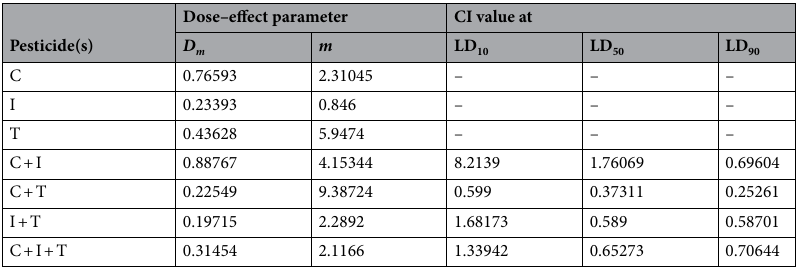
Table 2. Dose–effect relationship parameters and mean combination index (CI) values of chlorpyrifos (C), imidacloprid (I), and thiamethoxam (T) singly and in binary and ternary combinations in bumblebee tests after 48 h of exposure. The computer software CompuSyn was used to calculating the D m , m , r , and CI values. The parameters D m , m , and r are the antilog of the x -intercept, the slope, and the linear correlation coefficient of the median-effect plot, which indicate the potency (LD 50 ), the shape of the dose–effect curve, and the conformity of the data to the mass-action law, respectively 38–40 . The D m and m values were used to calculate the CI values (Eq. (4)), and CI < 1, CI > 1, and CI = 1 represent synergism, antagonism, and an additive effect, respectively. LD